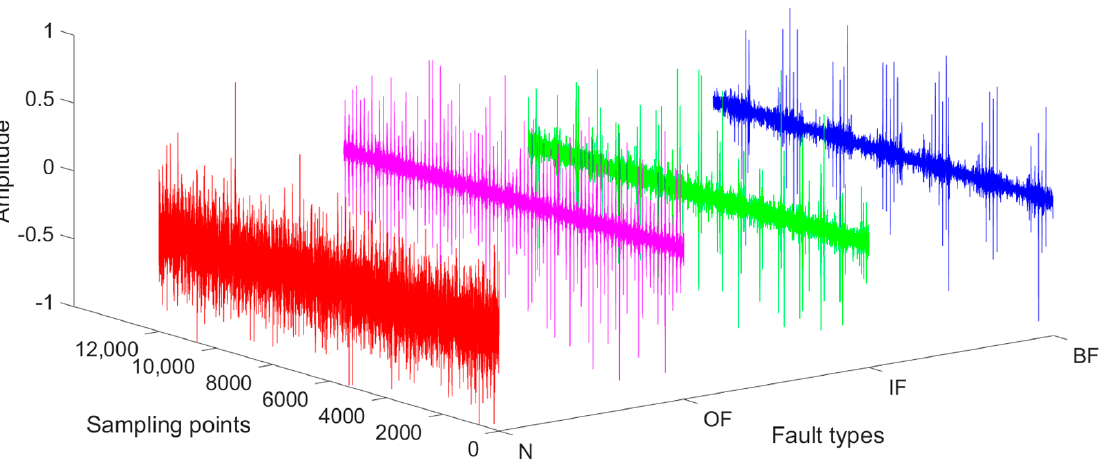
Figure 5. Simulation signals of normal, outer ring fault, inner ring fault, and rolling element fault.